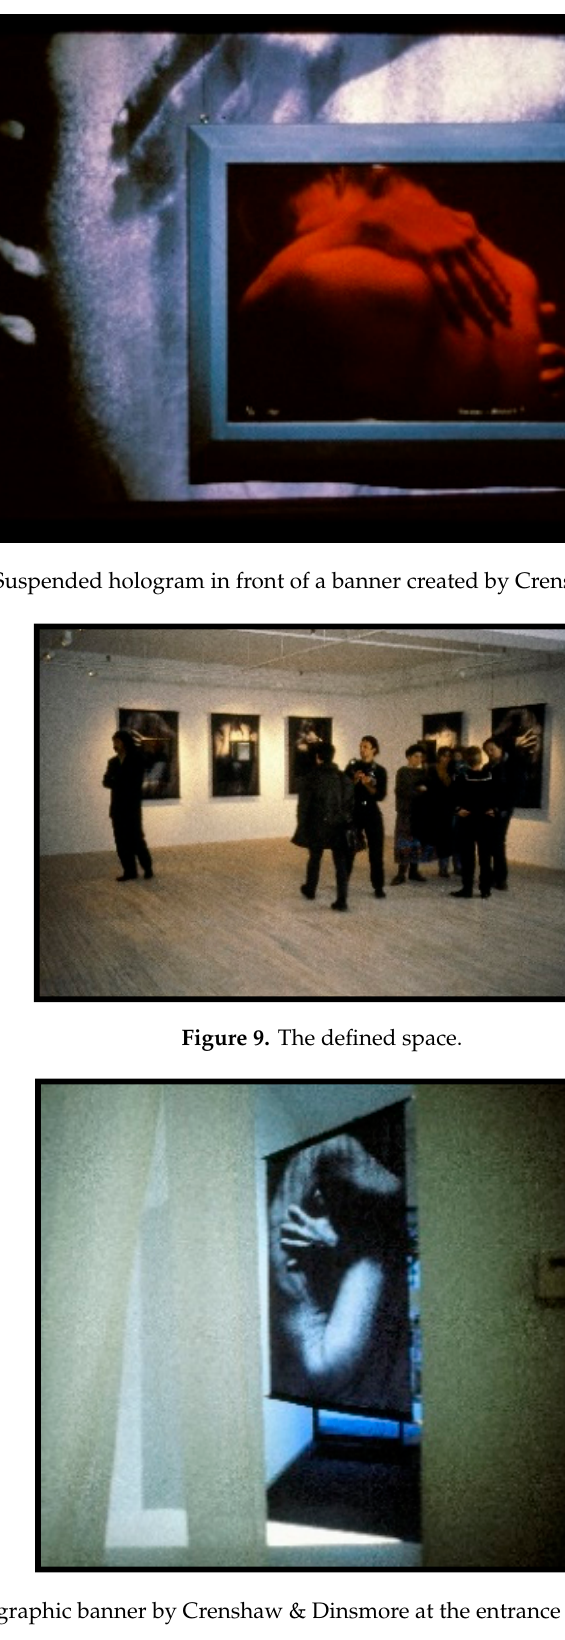
Figure 10. Photographic banner by Crenshaw & Dinsmore at the entrance to one of our exhibitions.